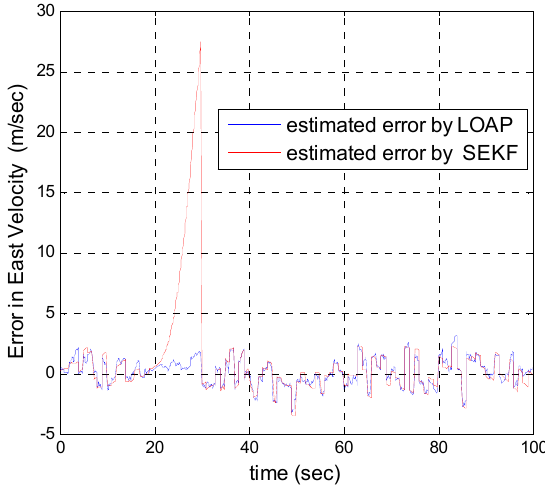
Figure 14. Error estimation of east velocity.